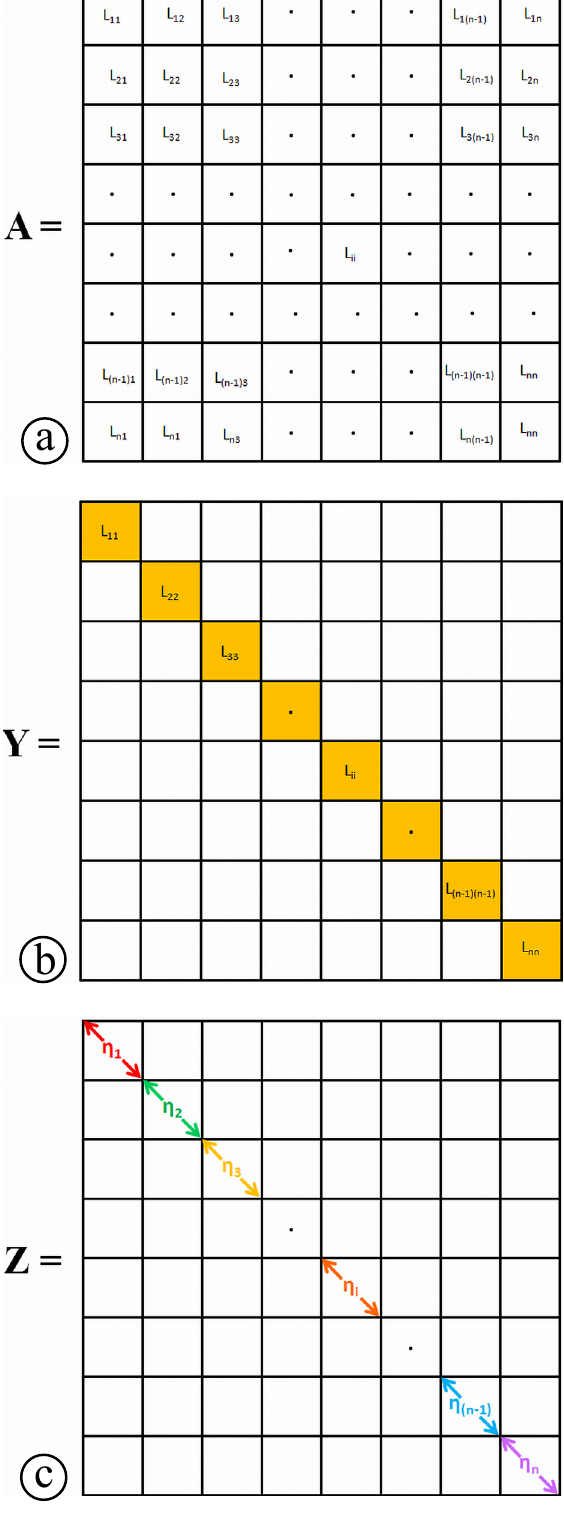
Fig.2: BMMR matrix formation: (a) A matrix formation by defining several block matrices in J T J matrix, (b) Y matrix formation from A matrix, (c) BMMR matrix or Z matrix formation from Y